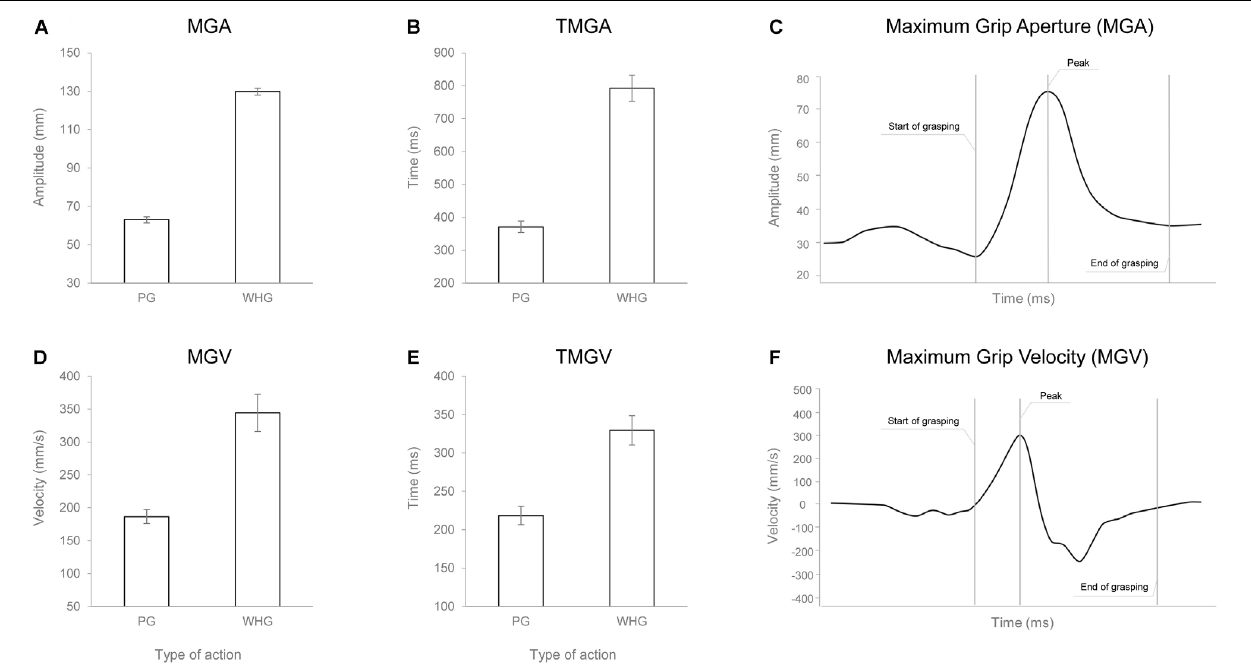
FIGURE 4 | Graphical representation of the mean values for MGA (A) , TMGA (B) , MGV (D) , and TMGV (E) when participants performed either a PG or a WHG. Bars represent SE of the mean. Example of the measure of the MGA (C) and MGV (F) peaks from a representative participant.